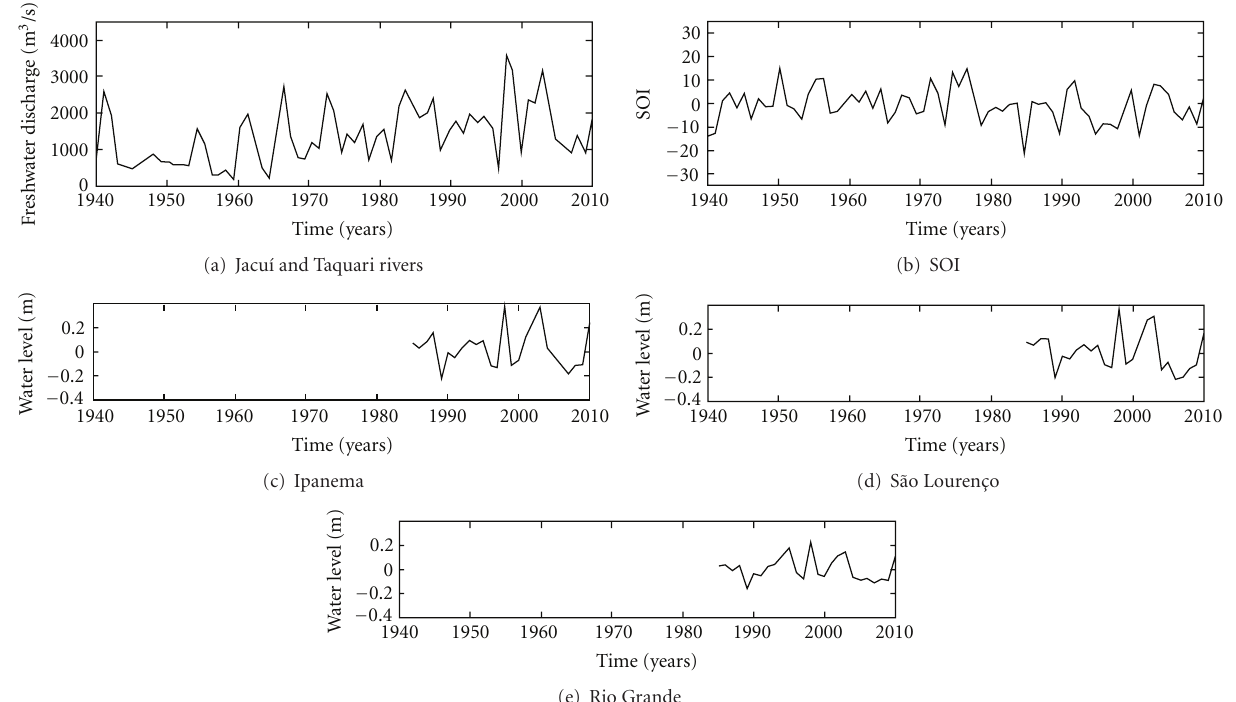
Figure 2: Temporal series of freshwater discharge (a) and SOI (b) for the period between 1940 and 2010. Temporal series of water levels at Ipanema (c), S˜ao Lourenc¸o (d), and Rio Grande (e) between 1985 and 2010.